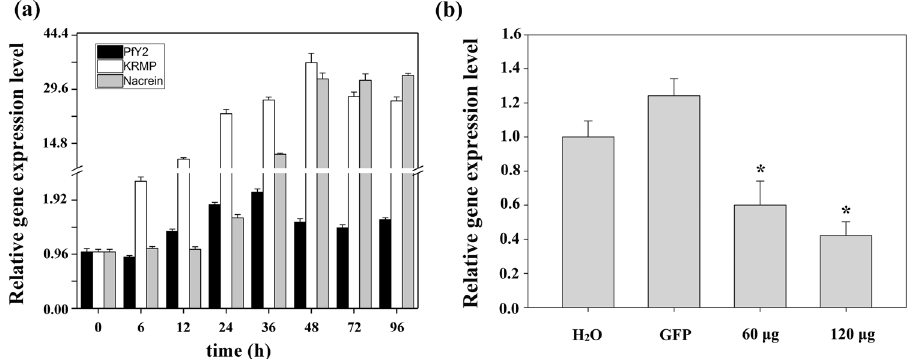
Figure 2. In vivo functions of PfY2. ( a ) PfY2 expression after shell notching. Expression of negative control (0 h) gave a relative value of 1.0. ( b ) PfY2 expression inhibited by RNAi. Negative control water-injected group gave a relative value of 1.0. The oysters in non-target control group were injected with GFP dsRNA. The expression of PfY2 was significantly ( p < 0.05) inhibited after the injection of specific PfY2 dsRNA in both 60 μ g and 80 μ g group compared with the oysters injected with water. Asterisk, significant difference ( p <